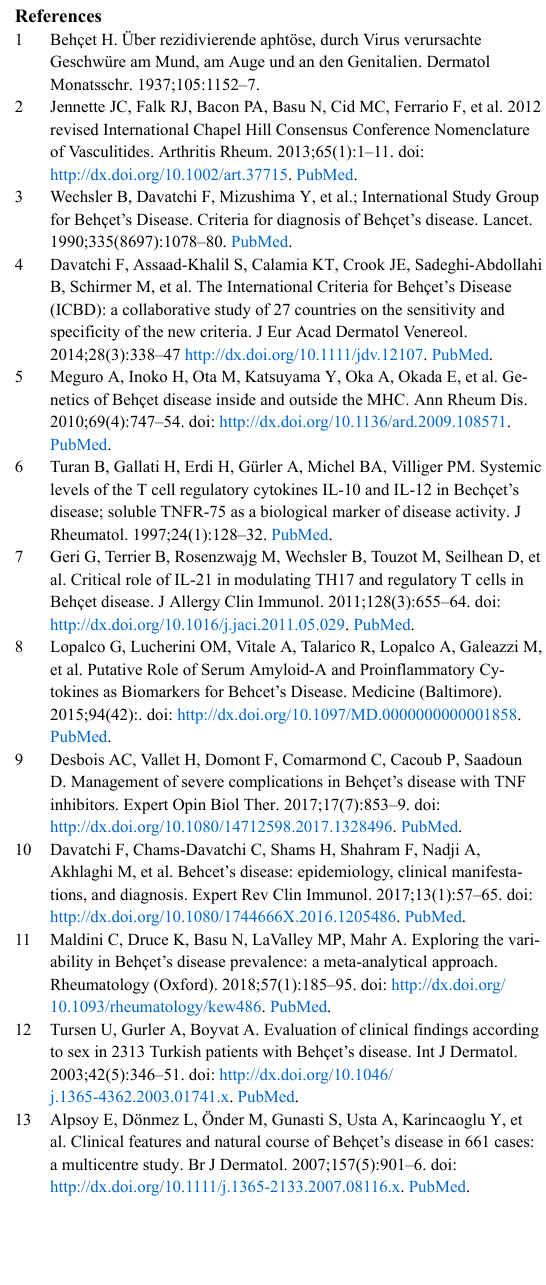
15 Table of the Bundesamt für Statistik, as of 31 December 2016: Bilanz der ständigen Wohnbevölkerung nach institutionellen Gliederungen, Staatsangehörigkeit (Kategorie), Geschlecht und demographischen Komponenten. Published 30 August 2017; BFS-Nummer: px- x-0102020000_201; Available at: https://www.bfs.admin.ch/bfs/de/ home/statistiken/kataloge-datenbanken/tabellen.assetde- tail.3262106.html 16 Table of the Bundesamt für Statistik, as of 31 December 2015; Region- alporträts 2017: Kennzahlen aller Gemeinden. Published 18 May 2017; BFS-Nummer: je-d-21.03.01; Available at: https://www.bfs.admin.ch/